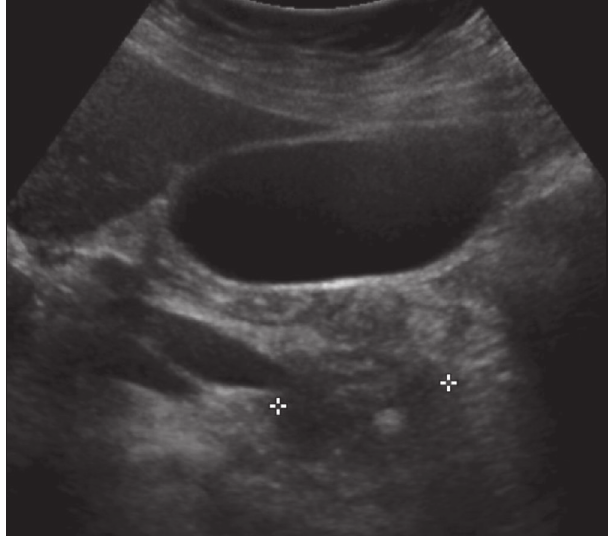
Figure 1) Ultrasound image demonstrating hypodense enlargement of the pancreatic head and regular marked tapering compatible with a stricture of the distal common bile duct. An echogenic focus in the pancreatic head is compatible with a calcification